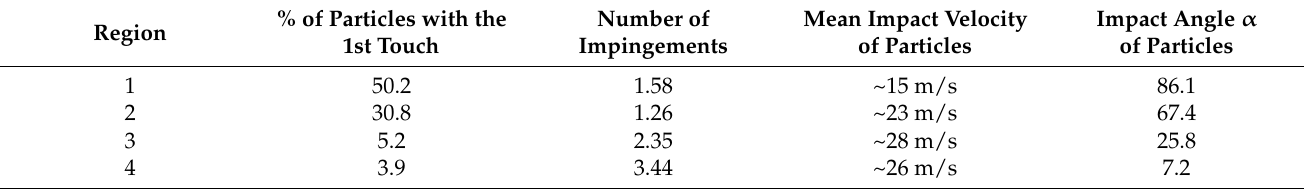
Table 4. Statistical values of the particle interaction with the workpiece